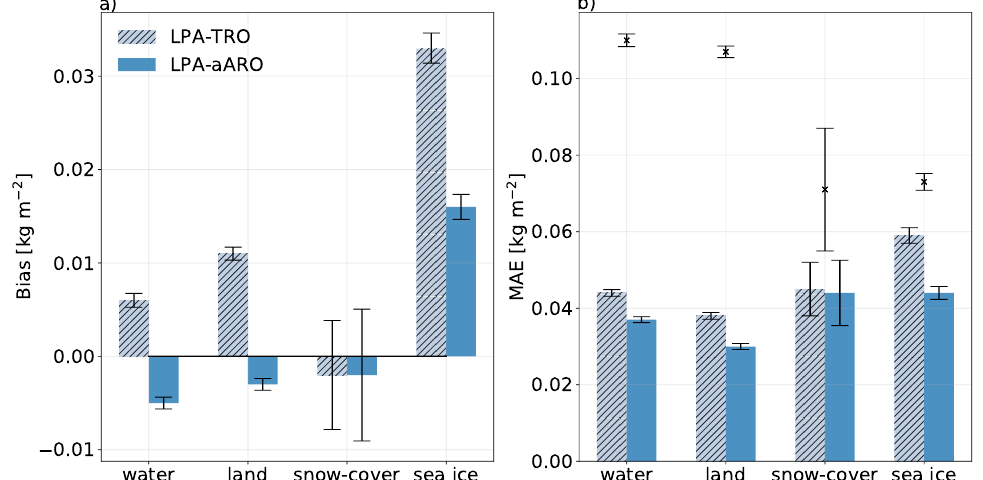
Figure 12. The ( a ) bias and ( b ) mean absolute error (MAE) of the retrieved IWPs (test data) using the aARO- and TRO-based databases for different surface types. The black crosses in ( b ) represent the mean of the reference IWPs. The error bars mark the one standard deviation around the mean, calculated by random sampling with replacement